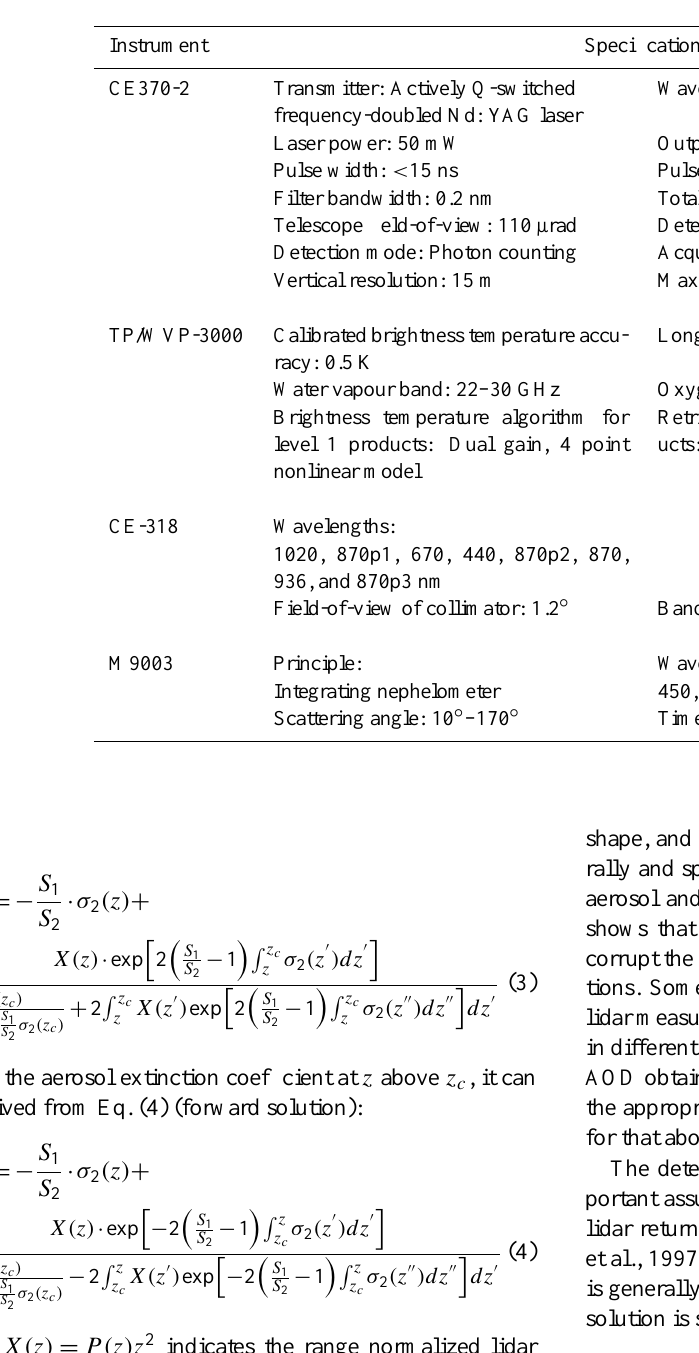
Table 1. Instrument